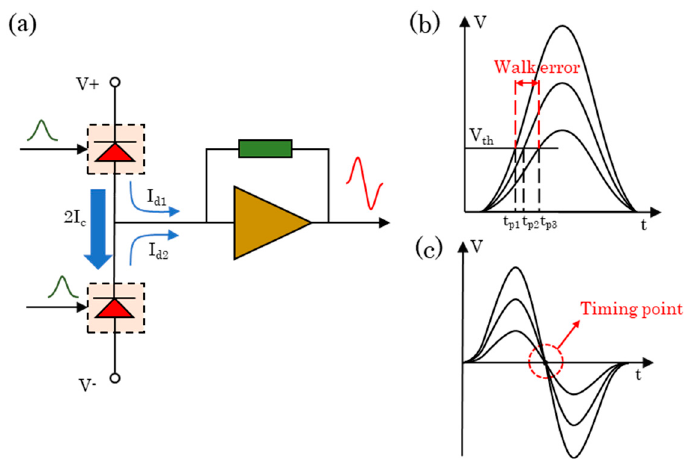
Figure 2. ( a ) The flow of photocurrent in the BPD. ( b ) Conceptual diagram of the walk error. ( c ) The bipolar signal with zero-crossing point as the timing moment.